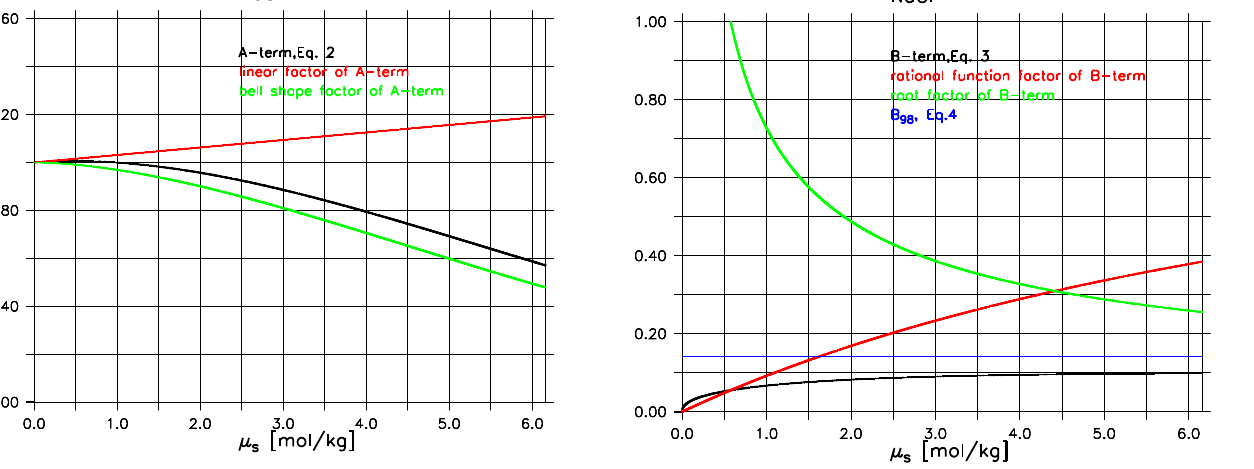
Fig. 8. B-term and its rational function and root term for NaCl. B 98 is also plotted for